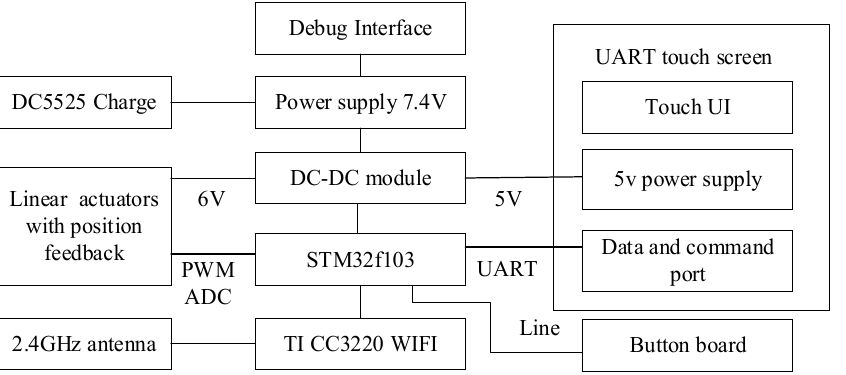
Figure 2. Control frame diagram of hand rehabilitation robot.